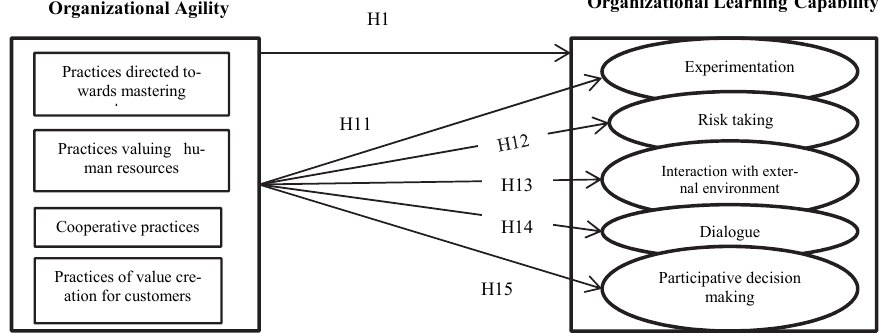
Fig. 1. Proposed Model of